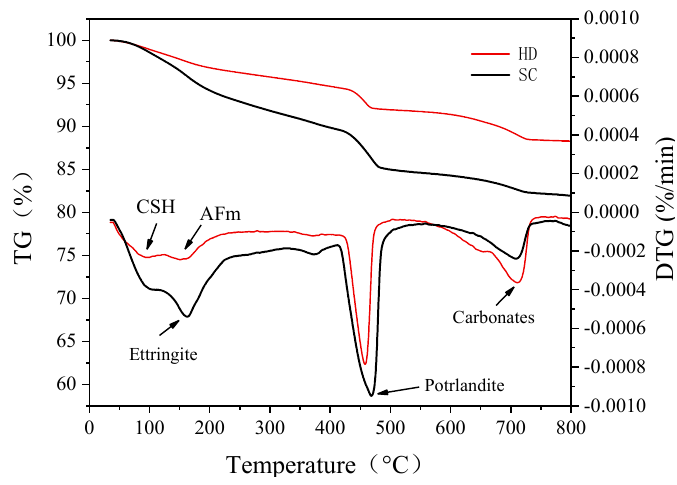
Figure 8. The TG-DTG curves of FA0-NP under different curing systems.